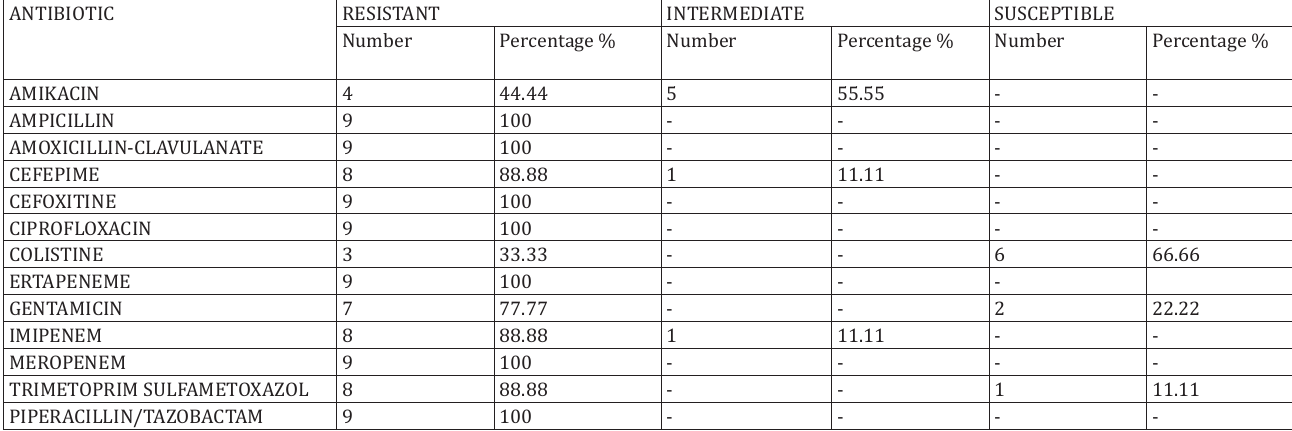
Antibiotic susceptibility test result of K. peumoniae isolates